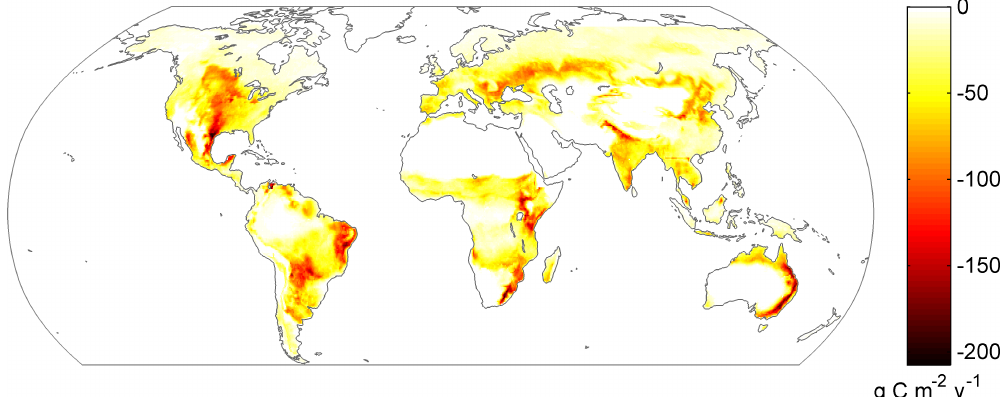
Figure 5. Global averaged map of negative 10th-percentile extreme events in GPP. The largest 200 10th-percentile extremes in GPP for each continent and the four data sets MTE, MOD17+, LPJmL and OCN were computed and then averaged to obtain the typical impact of GPP extreme events per year. Compare with Figure 3A in Zscheischler et al. (2014) for an analysis at the global scale.